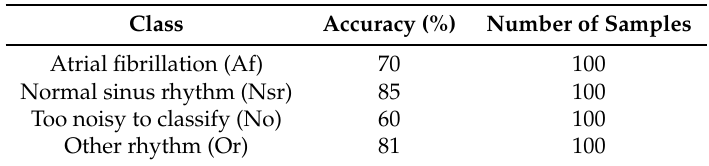
Table 2. Accuracy for each class in frequency domain.Samples used are the same ECG signals converted into